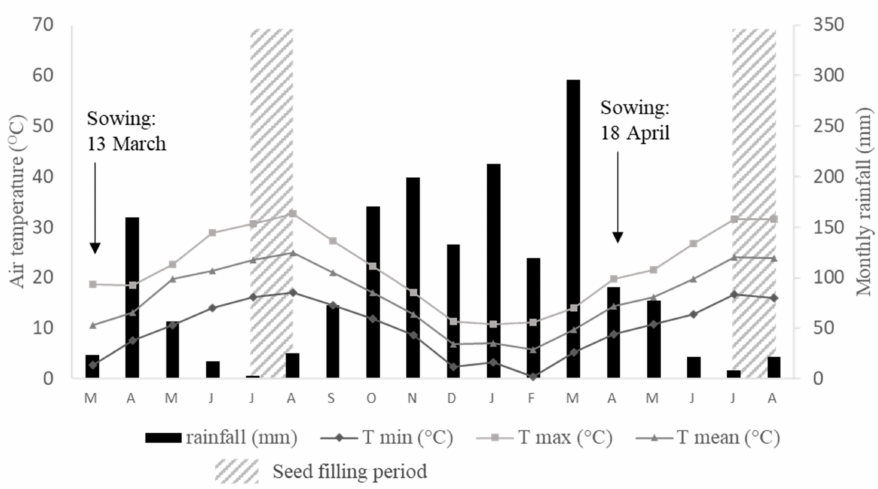
Figure 1. Monthly rainfall and mean, minimum, and maximum temperatures for the trial period with indications of sowing dates and reproduction stages susceptible to environmental stress (dashed grey